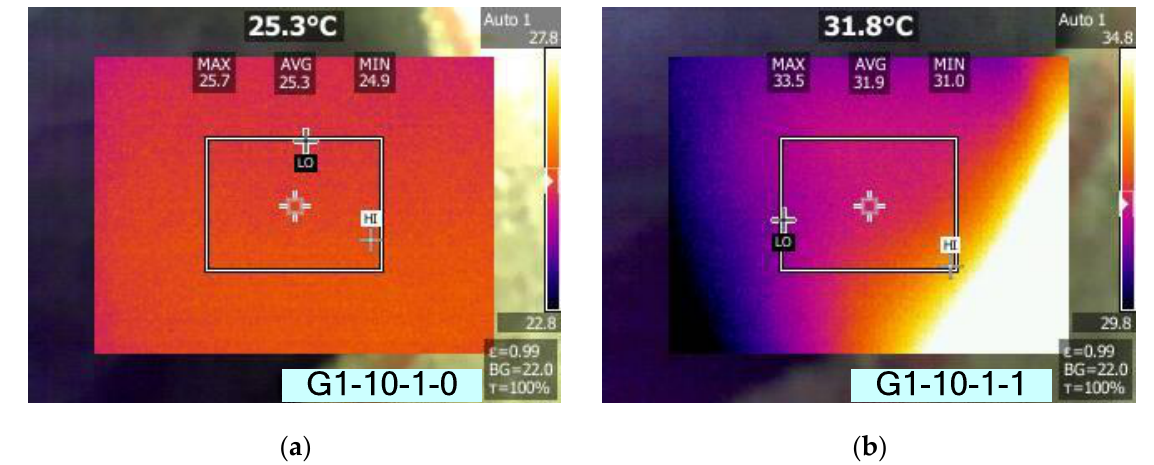
Figure 18. Spectrogram of gangue samples with size of S1 before and after microwave irradiation of 10 s. ( a ) Before microwave irradiation; ( b ) After microwave irradiation. (6) After the test of a group of samples, the microwave oven is cooled to the initial